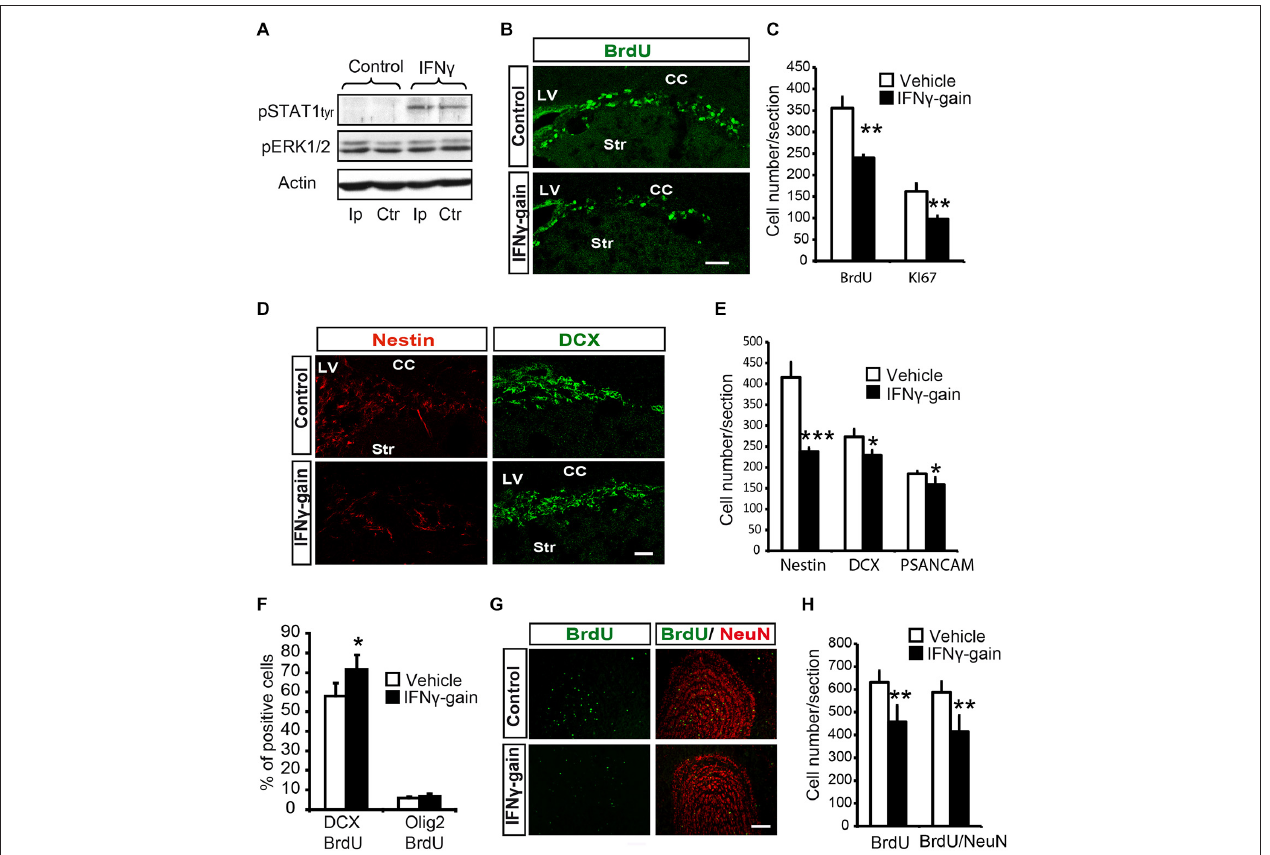
(F) Histograms summarizing cellular fate determination (expressed as percentage) in animals injected with BrdU at time 0 and with a pump implanted for 4d. Neuronal fate determination (BrdU+/DCX+) was significantly increased and glial production (BrdU+/Olig2+) was unaltered by IFN γ ( n = 5). (G) Pictures of the OB showing the presence of BrdU+, NeuN+ and BrdU+/NeuN+ labeled cells in IFN γ -gain mice. The number of newborn cells (BrdU) and neurons (BrdU/NeuN) were reduced in the animals in which IFN γ activity was induced. (H) Histograms summarizing the quantification of total number of newborn cells and neurons per section in the OB of controls and IFN γ -gain animals ( n = 5). The number of newborn cells (BrdU+) and neurons (BrdU+/NeuN+) was reduced in the presence of IFN γ . Scale bar: (B, D) and (G) 100 µ m. Data are represented as mean ± SEM. * p ≤ 0.05; ** p ≤ 0.01; *** p ≤